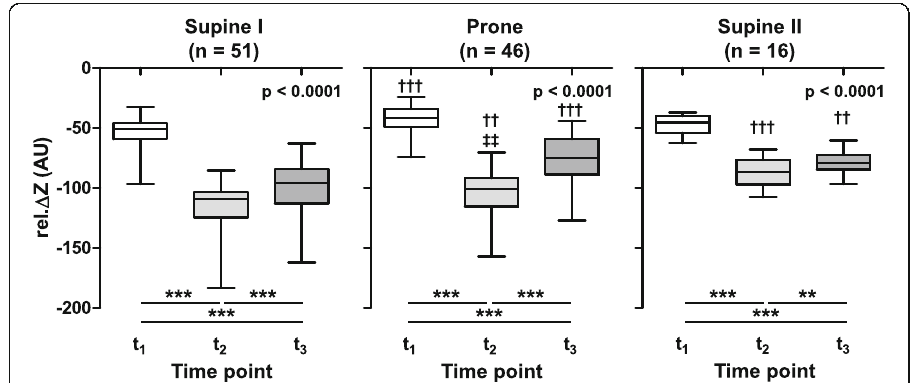
The sums of all calculated pixel values of rel. Δ Z obtained for all data sets in the supine I, prone and supine II positions at t a decrease in bioimpedance (fall in rel. Δ Z ) after disconnection from the ventilator, a further significant fall after the fluid instillation, and an increase after suction (Fig. 3). The rel. Δ Z values remained significantly lower by the end of fluid recovery than after